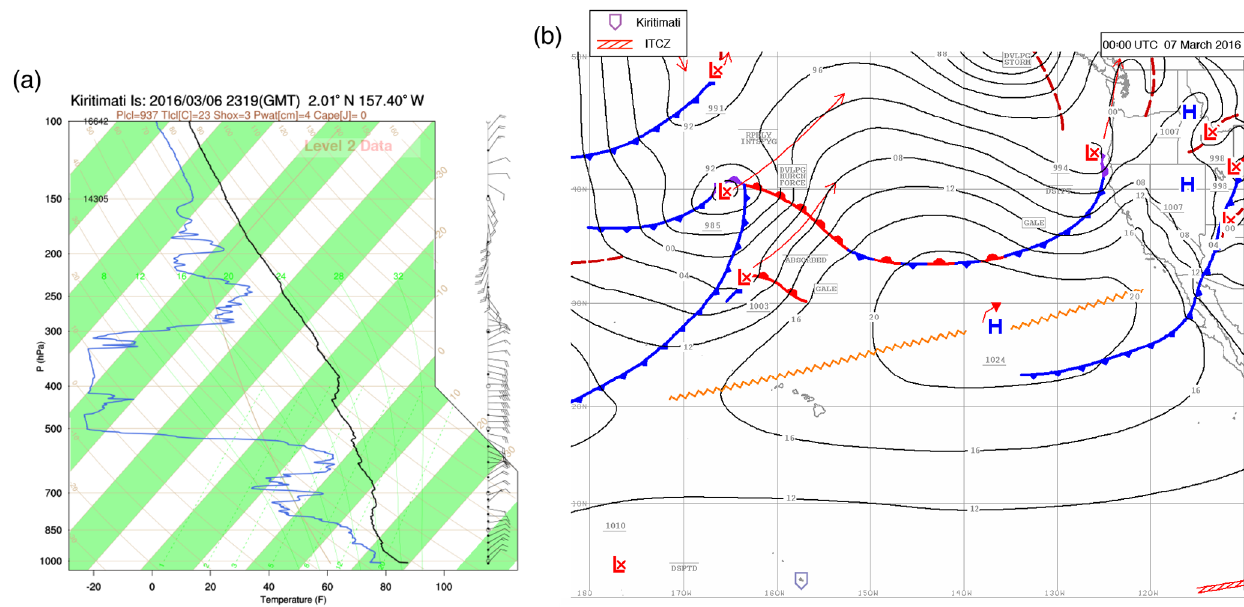
Figure 10. The 7 March 2016, 00:00UTC sounding, which featured extremely dry air between 300 and 500hPa, was the driest one collected at CXENRR. A coincident surface analysis shows a strong subtropical high-pressure system east-northeast of Hawaii and the Northern Hemisphere ITCZ confined to the furthest eastern regions of the Pacific, leaving Kiritimati (2.0 ◦ N, 157.4 ◦ W) and the rest of the central equatorial Pacific in a broad zonal band of weak surface pressure gradients.